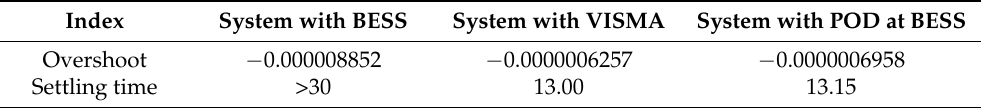
Table 7. Detailed features of G4 response.